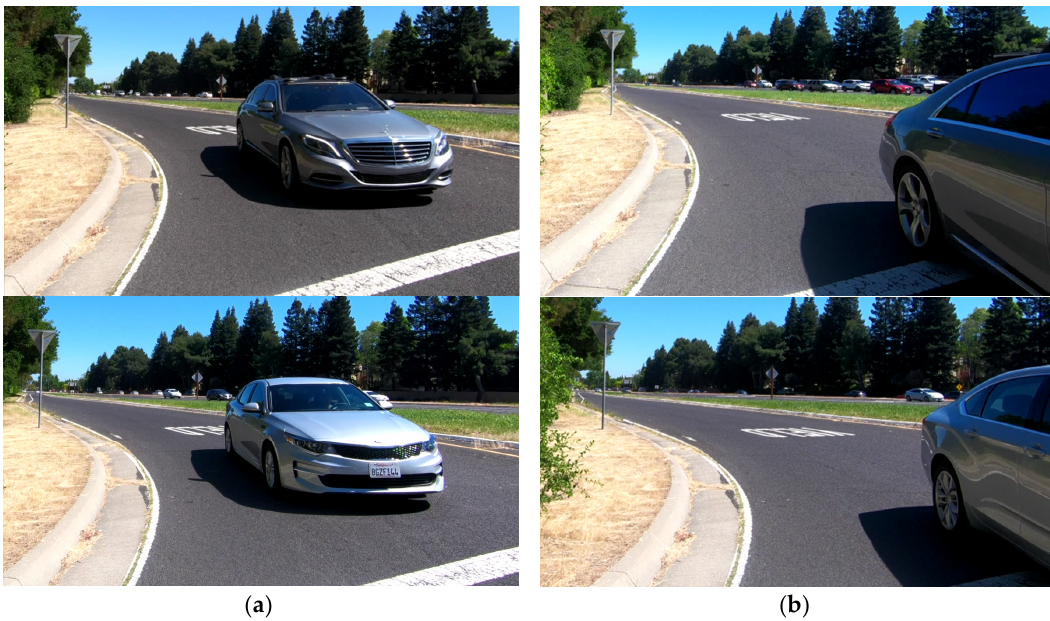
Figure 2. The study compared three eHMI test conditions within a driverless self-driving vehicle (SDV). This figure shows the status + intent eHMI (test condition 3). Two steady lights at the fake sensors indicate the automated status; a slowly flashing light at the windshield indicates its intent to yield to the pedestrian. For the status eHMI (test condition 2), the two steady lights were engaged. Without an eHMI (test condition 1), no lights were engaged. Reproduced with permission from Faas, Kao and Baumann, A longitudinal video study on communicating status and intent for self-driving vehicle–pedestrian interaction, Proceedings of the SIGCHI Conference on Human Factors in Computing Systems (CHI ’20) ; published by ACM, 2020, doi: 10.1145 / 3313831.3376484.